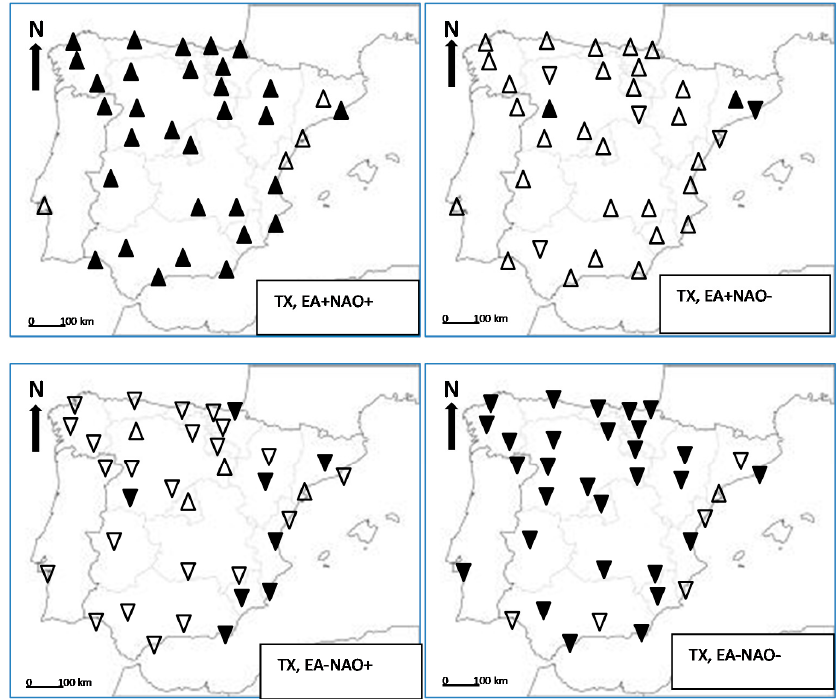
Figure 5. Difference of TX mean values for each EA-NAO composite and the mean of the complete period 1950–2019 for winter. Triangle up (down) means positive (negative) difference, full (empty) triangle means significant (not significant) difference at the 95% confidence level.